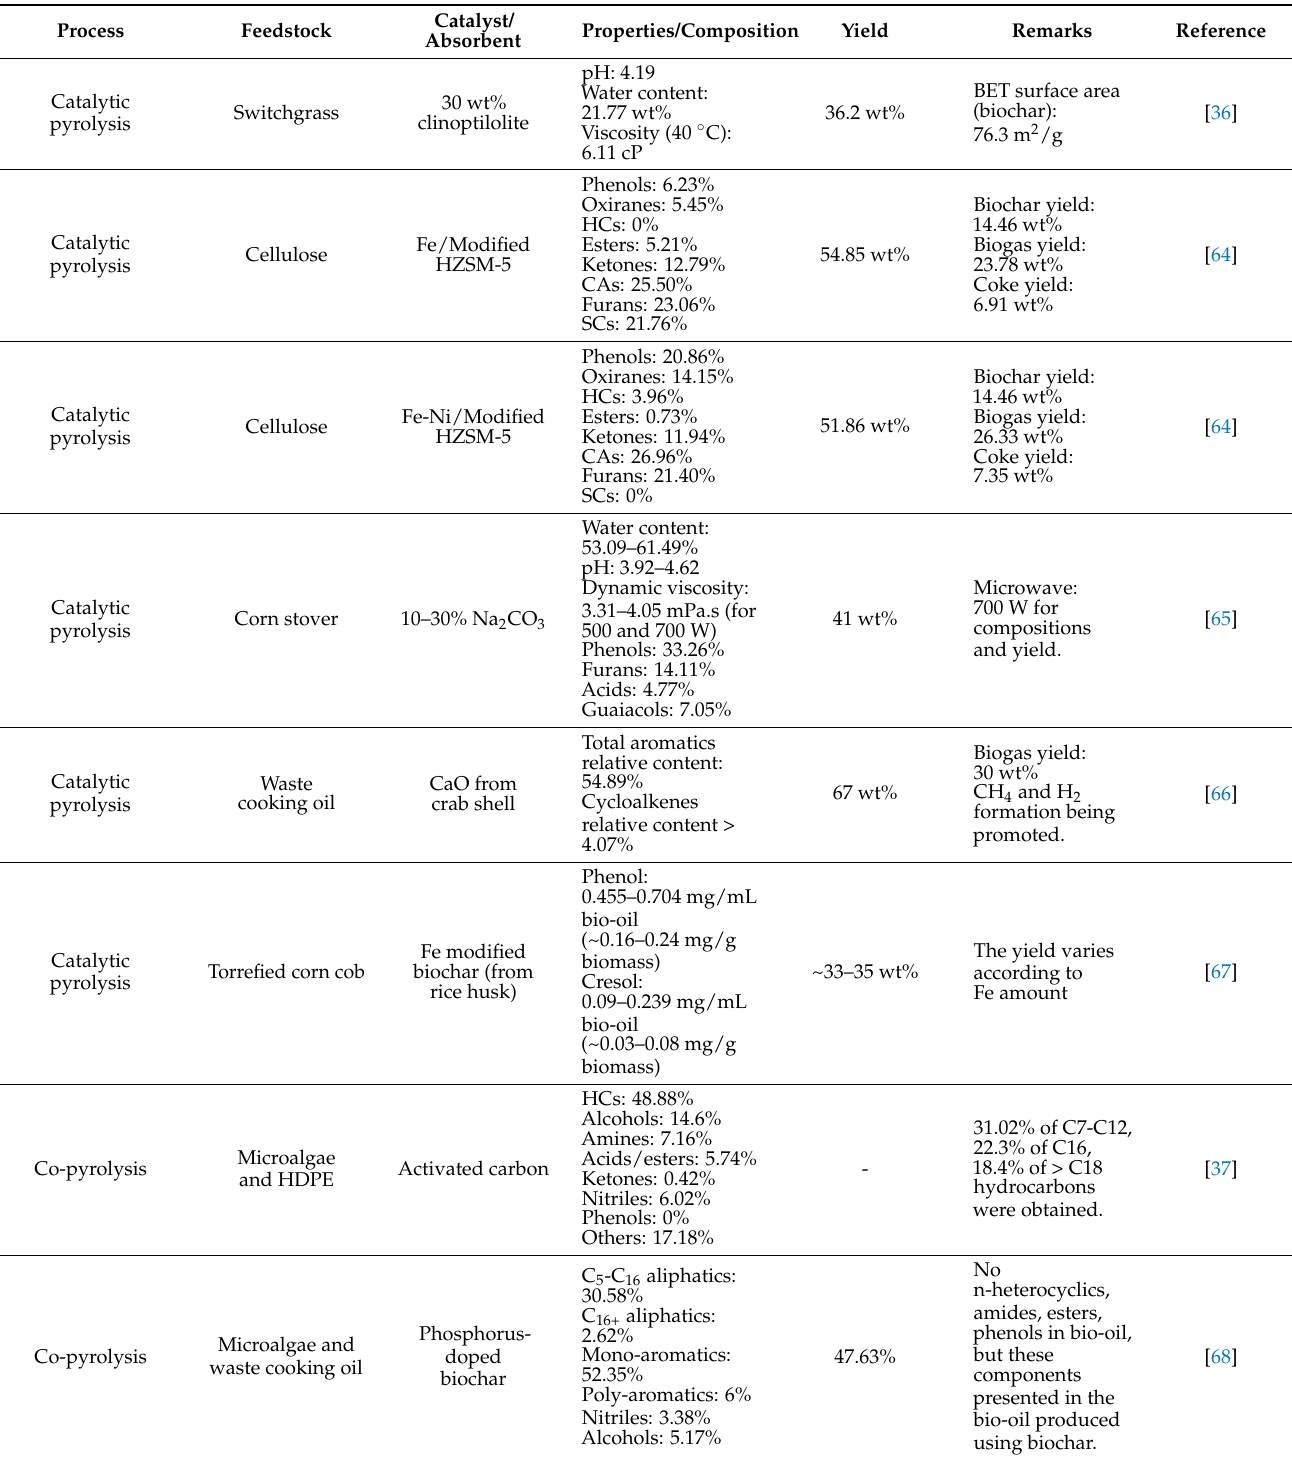
Table 4. The bio-oil production using microwave-assisted